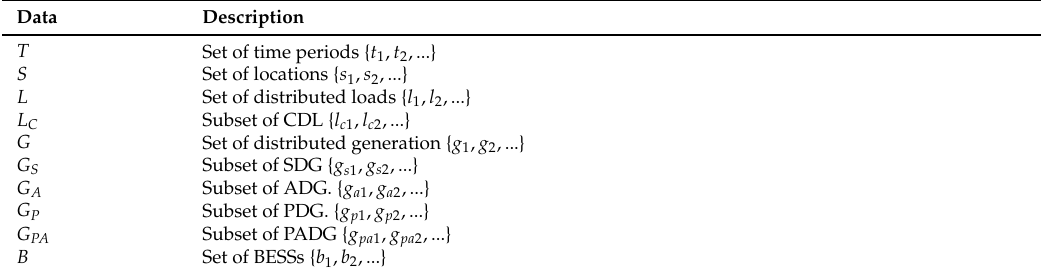
Table 1. Summary of input data (sets).